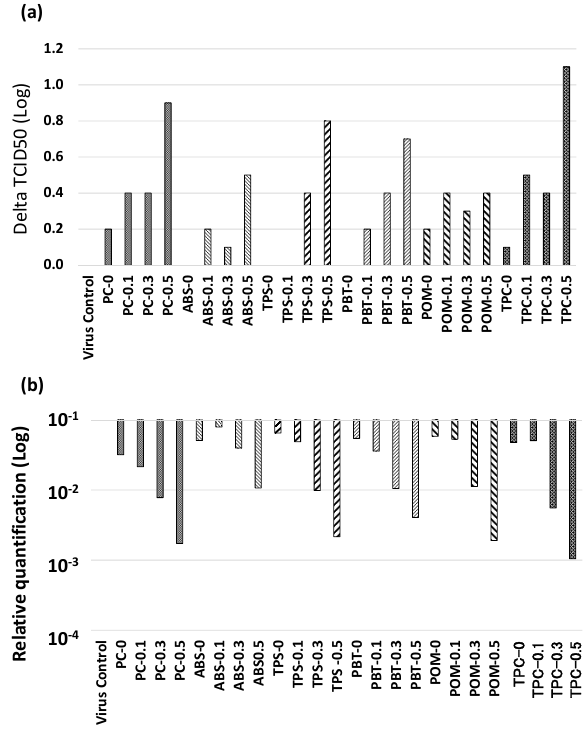
Figure 5. E ff ects of VB on molded materials. ( a ) TCID 50 assay; ( b ) relative quantitative Figure 5.